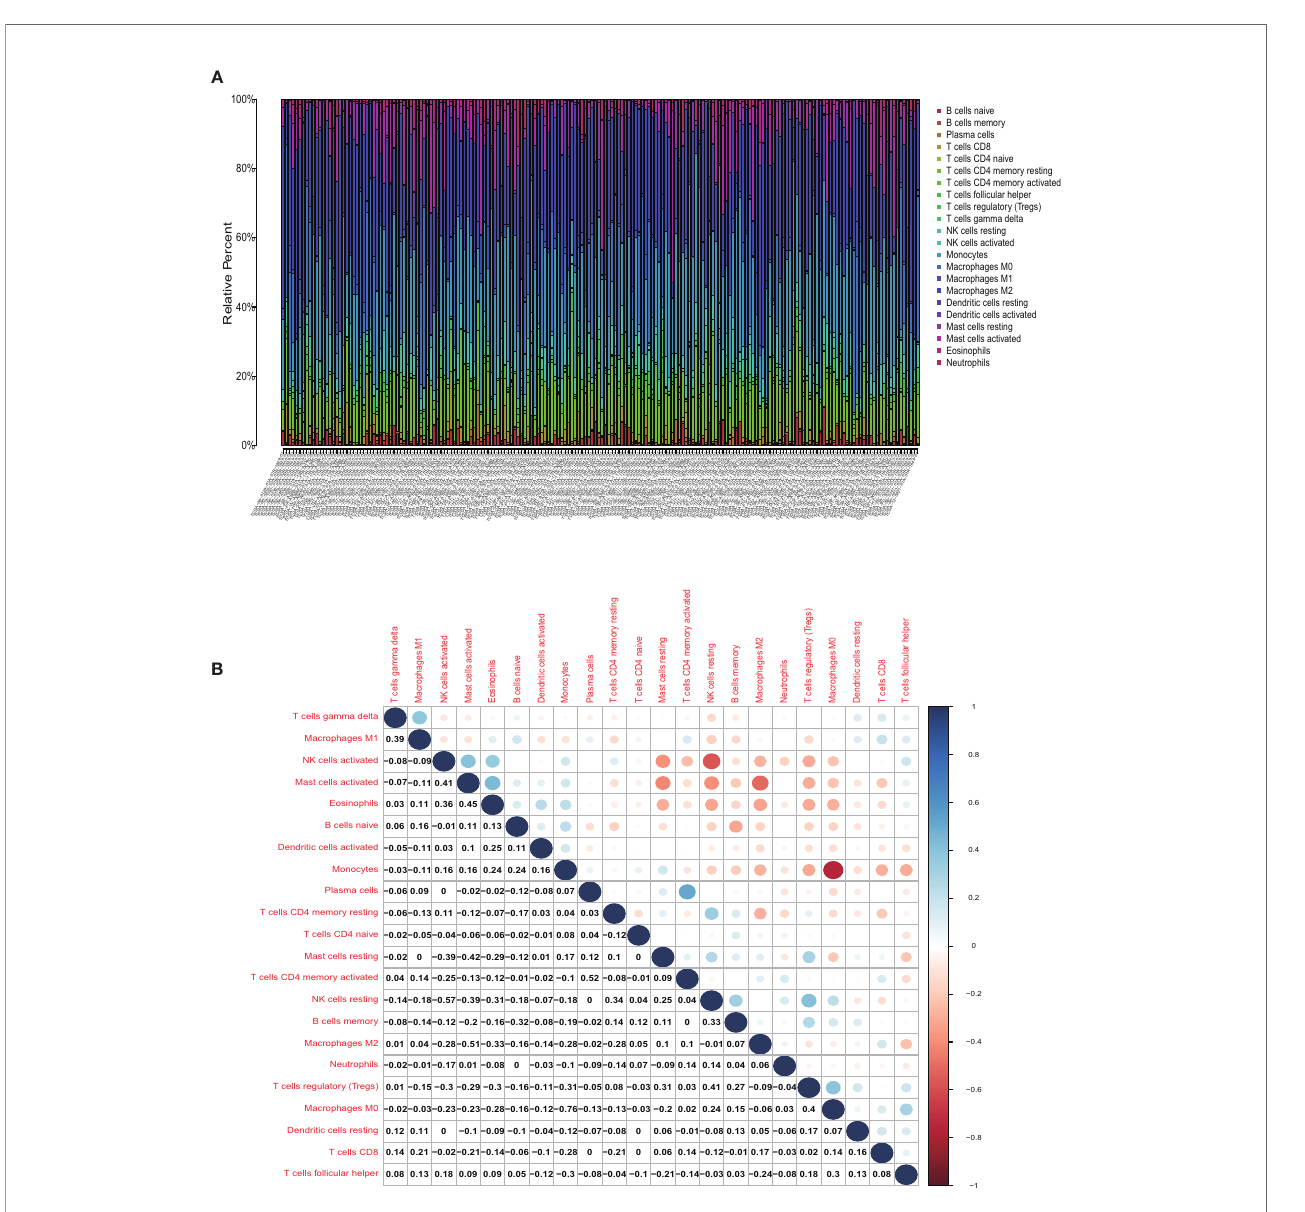
FIGURE 5 | Macrophage M2 accounted the largest portion of the TIICs. (A) The fi rst three largest portion of immune cells were Macrophage M2, Monocytes and CD4 memory resting cells. (B) correlation of different immune cells showed that the Macrophage M2 and Mast cells activated was negatively